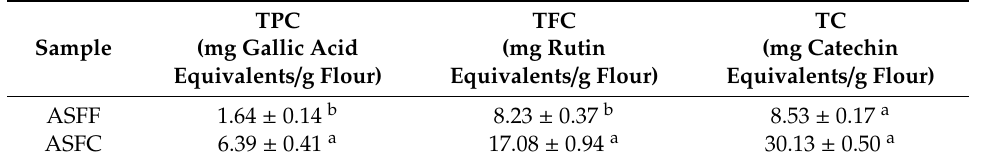
Table 3. Total phenolic, total flavonoid and tannins content of almond skin flours obtained from Turrón coproducts.